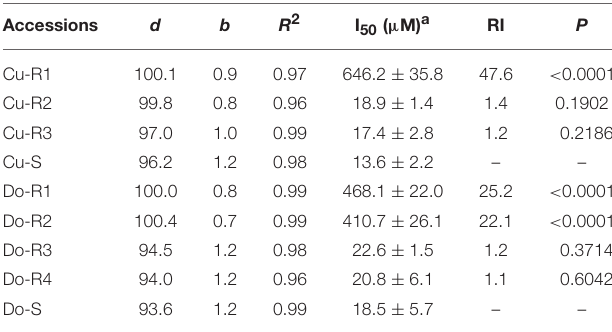
TABLE 5 | Parameter estimates of the equation used to calculate the sensitivity of EPSPS enzyme activity to glyphosate in extracts from leaf tissue of the different accessions of P. hyterophorus from Cuba and Dominican